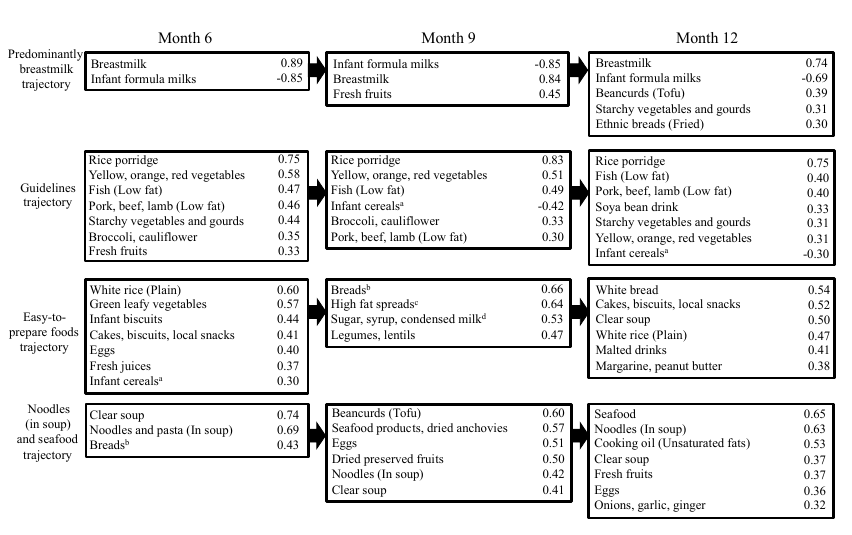
Figure 1. Mapping of dietary patterns at age 6, 9 and 12 months to trajectories. Only foods with loadings ≥ ±0.30 are shown in the figure. A full list of food items and their loadings are provided in Supplementary Materials. a Includes rice, wheat and oat baby cereals; b Includes white and whole wheat breads, breads with fillings or toppings, and baked ethnic breads; c Includes butter, ghee, peanut butter and margarine; d Added to drinks and